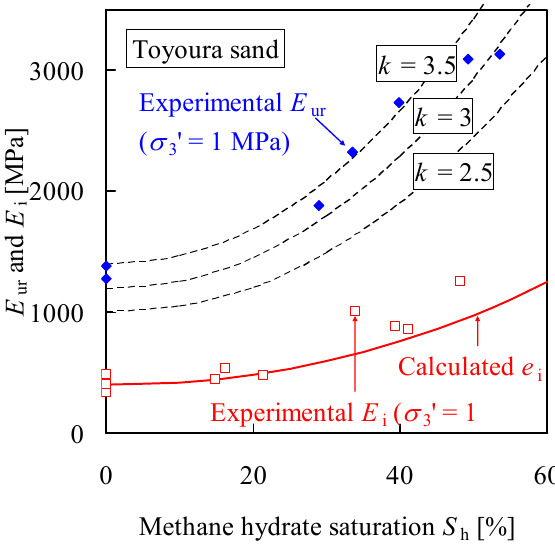
and initial tangent modulus E Figure 13. Unloading modulus E ur for specimens formed by Toyoura sand under 1 MPa effective confining saturation S h calculated using Equations (13) and (15–17). The broken pressure. The solid line denotes e i lines are k -times the calculated e i